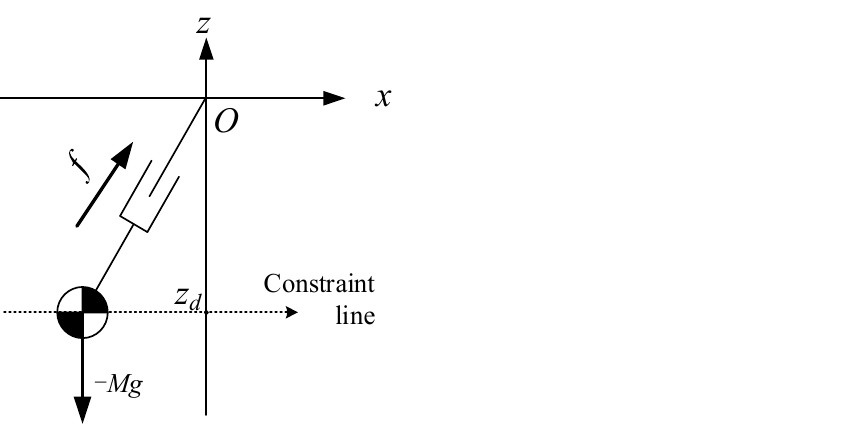
Figure 5. Linear pendulum model-center of mass (LPM-CoM) moving with a constant height.